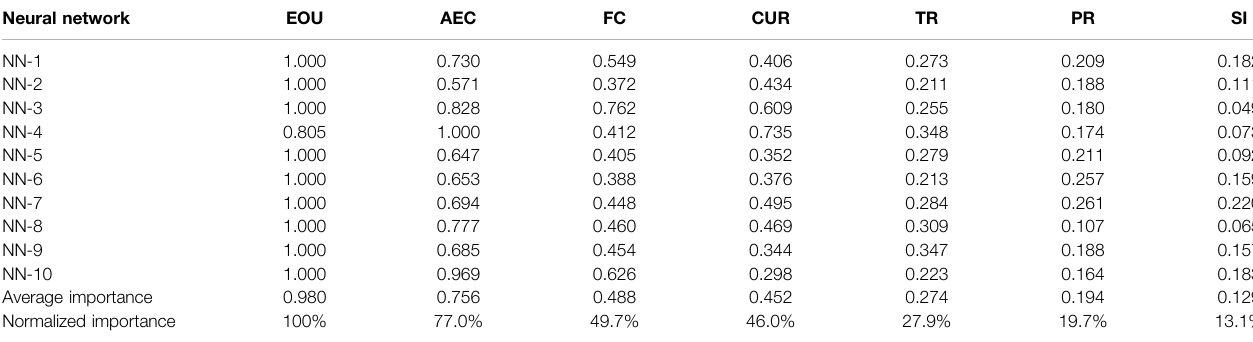
TABLE 7 | Sensititvity